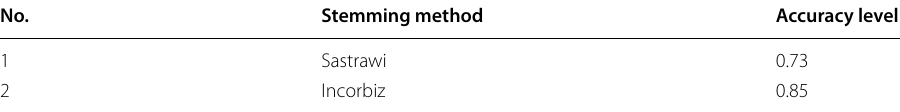
Table 5 The accuracy level of classifier model by using “Sastrawi” and “Incorbiz” No. Stemming